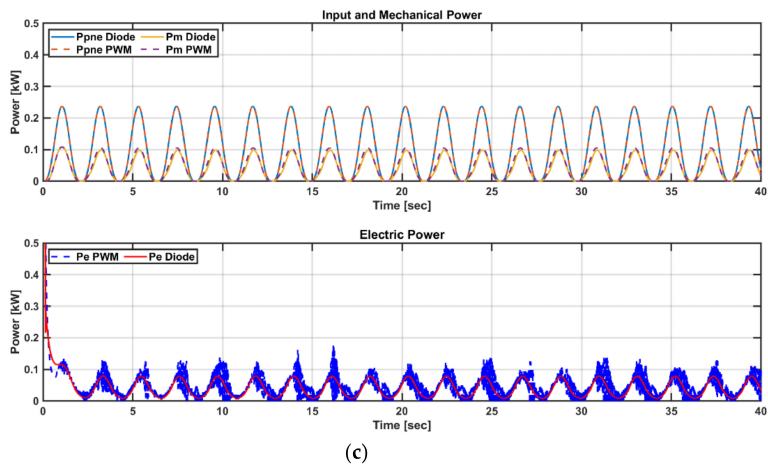
Figure 15. Power performance results of the PTO system in the integrated simulation under the low regular wave condition ( v t = 0~5 m / s and T = 4.25 s): ( a ) Diode converter; ( b ) PWM converter; ( c ) Comparison of power performance according to topology.